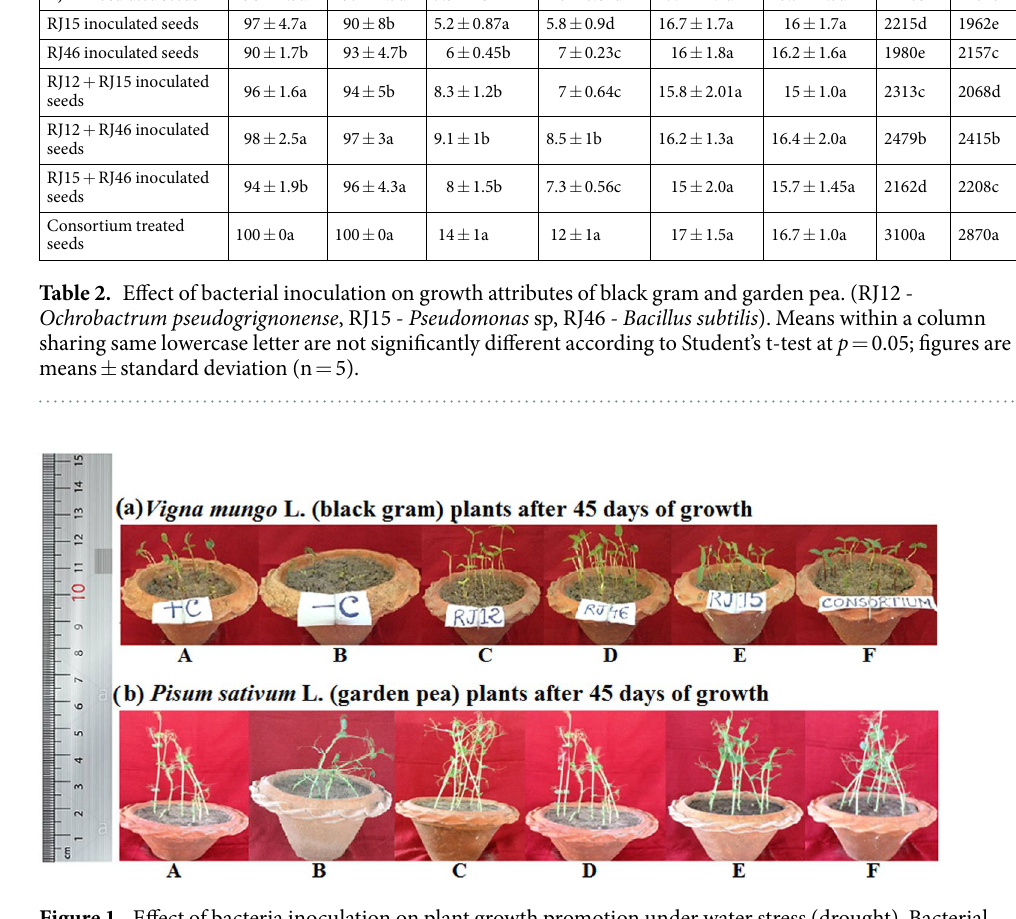
Figure 1. Effect of bacteria inoculation on plant growth promotion under water stress (drought). Bacterial individual and combined effect (consortium) increases survival rate of ( a ) black gram and ( b ) garden pea plants after 45 th days of growth stress induction as compared to the negative control (stressed plants without inoculation). A - uninoculated watered plants as positive control, B- uninoculated plants under drought stress as negative control, C – inoculated with Ochrobactrum pseudogrignonense RJ12 under water stress, D – inoculated with Bacillus subtilis RJ46 under water stress, E – inoculated with Pseudomonas sp. RJ15 under drought stress, F – consortium ( Ochrobactrum pseudogrignonense RJ12 + Bacillus subtilis RJ46 + Pseudomonas sp. RJ15) inoculated plants with drought